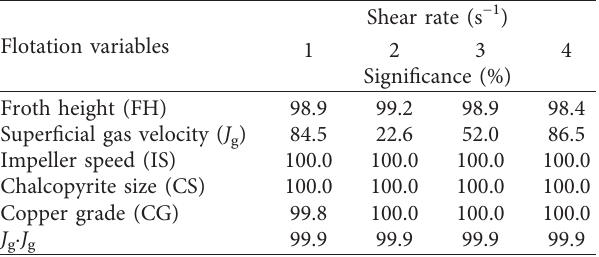
Table 2: Significance of flotation variables on froth apparent viscosity at different shear